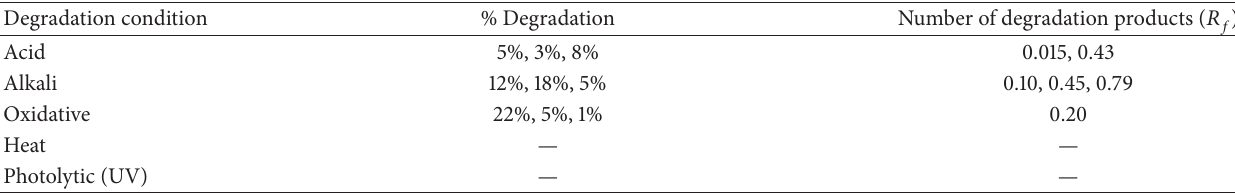
Table 5: Results from degradation